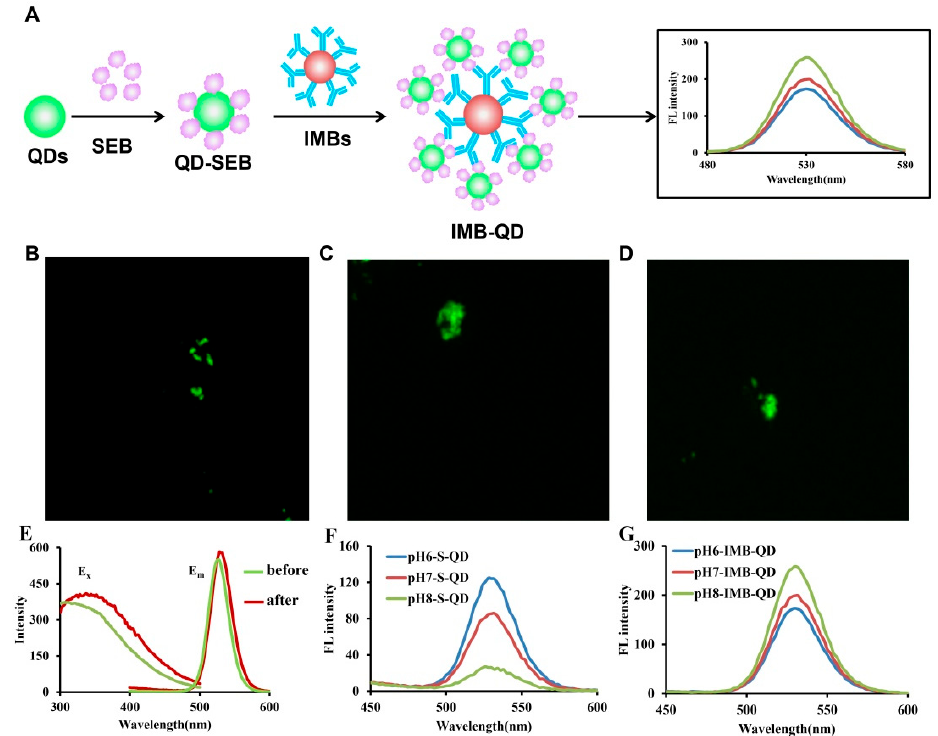
Figure 5. Fluorescence analysis of antibody orientation on MBs. ( A ) Schematic represent for fluores- cence analysis, fluorescence microscopy images of pH6-IMB-QD ( B ), pH7-IMB-QD ( C ) and pH8-IMB-QD ( D ), the excitation and emission spectra of QDs and QD-SEB complexes ( E ), fluorescence (FL) intensity analysis of QDs in the supernatant ( F ) and IMB-QD complexes ( G ).